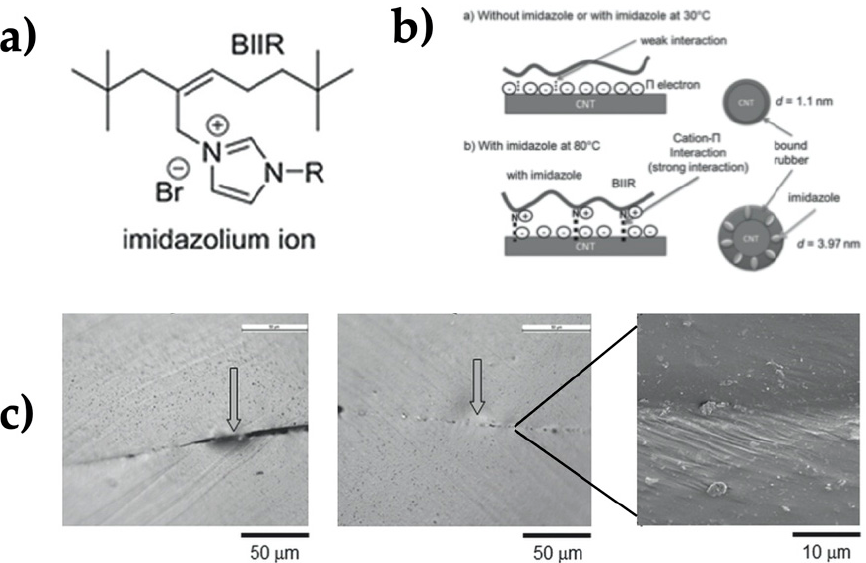
Figure 10. ( a ) Chemical structure of butyl bromide polymer bearing imidazole groups, ( b ) interactions between BIIR and CNTs, and ( c ) SEM images of self-healing after cut the surface [102]. Adapted with permission from Le,H.H; Macromolecular Materials and Engineering; published by Wiley, 2017.